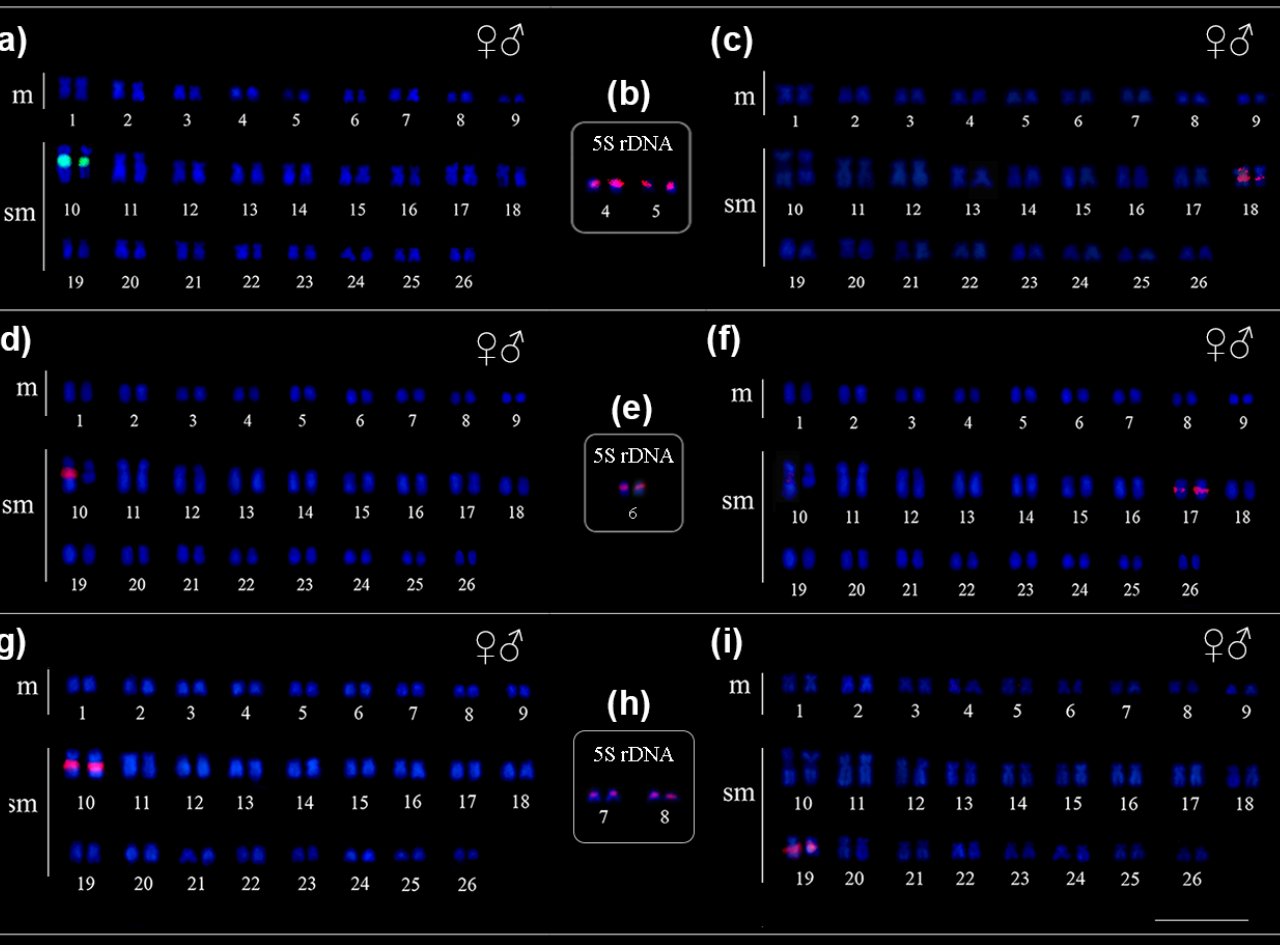
Figure 3. Fluorescence in situ hybridization indicating the physical location of telomeric sequences in the karyotypes of P seudacanthicus species . In ( a ) P. spinosus , in ( b ) P. leopardus , and in ( c ) Pseudacanthicus sp. Hybridization signals were detected with FITC (green) and Cy3 (red), chro- mosomes were counterstained with DAPI (blue).